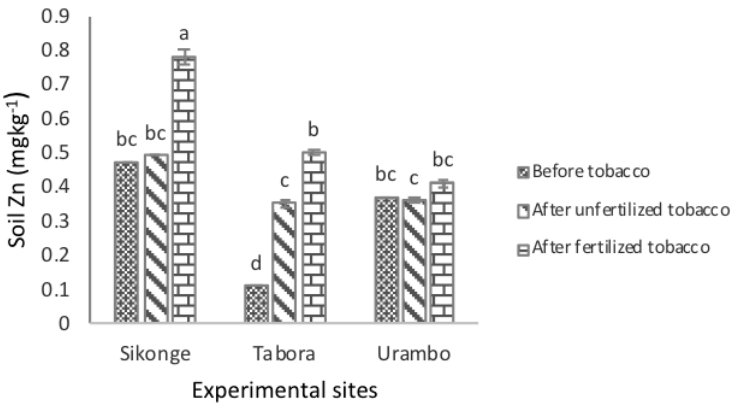
Figure 5. The effect of tobacco and NPK + CAN fertilization on the extractable Zn in soils. 2.3. The Effect of Fertilization with NPK and CAN on Micronutrient Concentrations in Tobacco Leaves The leaf concentrations of the extractable micronutrients (B, Cu, Fe, Mn, and Zn) in tobacco are presented in Table 2. The leaf concentration of the extractable Mn differed significantly ( P < 0.001) across the sites. The leaf extractable B (15.58 mg kg − 1 ) of tobacco cultivated in the Sikonge site was significantly ( P < 0.001) higher than those in the Urambo (14.60 mg kg − 1 ) and Tabora (13.93 mg kg − 1 ) sites. Tobacco cultivated in the Urambo site had a leaf extractable Cu concentration of 12.03 mg kg − 1 which was significantly ( P < 0.001) higher than those recorded in leaves of tobacco cultivated in Sikonge and Tabora, each with the extractable Cu of 8.71 mg kg − 1 . Tobacco cultivated in the Tabora site had leaf extractable Fe (232.40 mg kg − 1 ) and Zn (17.94 mg kg − 1 ) which were significantly ( P < 0.001) higher than those recorded in the Sikonge (Fe 139.68; Zn 13.64 mg kg − 1 ) and Urambo (Fe 139.27; Fe 13.53 mg kg − 1 ) sites. In the comparison of leaf concentrations of fertilized and unfertilized tobacco, the results indicated that the extractable B, Cu, Mn, and Zn increased significantly ( P < 0.001) upon the fertilization of the tobacco plants. There was no significant increase in leaf extractable Fe concentration for unfertilized and fertilized tobacco. Furthermore, there were significant interaction effects of the sites and fertilization of the tobacco for leaf extractable Cu ( P < 0.001) and Mn ( P = 0.05). However, there were no significant interaction effects of the sites and fertilization on leaf concentrations of the extractable B, Fe, and Zn.